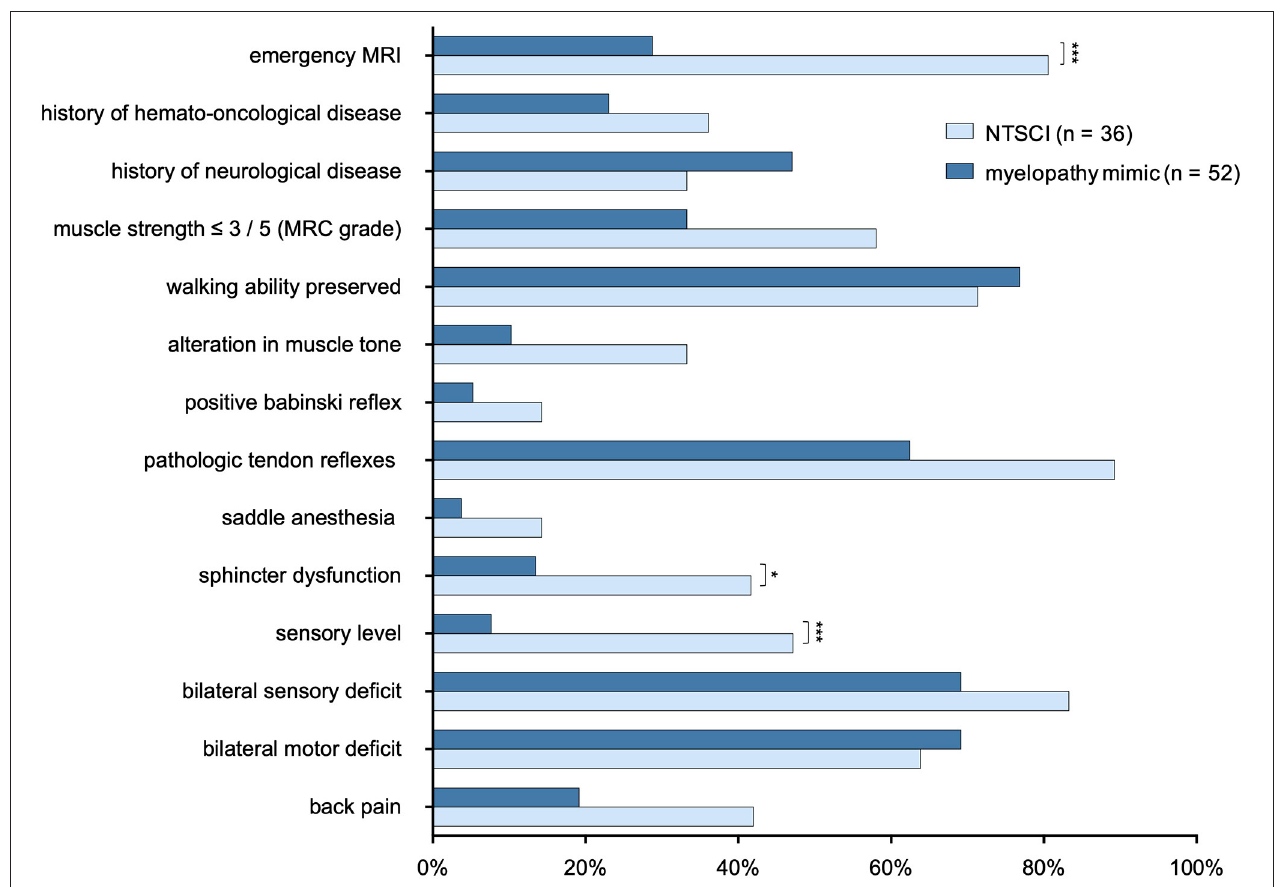
FIGURE 5 | Comparison of neurological examination and medical history in patients with NTSCI and myelopathy mimics. MRC, Modified Medical Research Council; MRI, magnetic resonance imaging; * p < 0.05; *** p < 0.001 ( p -values adjusted for multiple comparisons using false discovery rate (Benjamini &